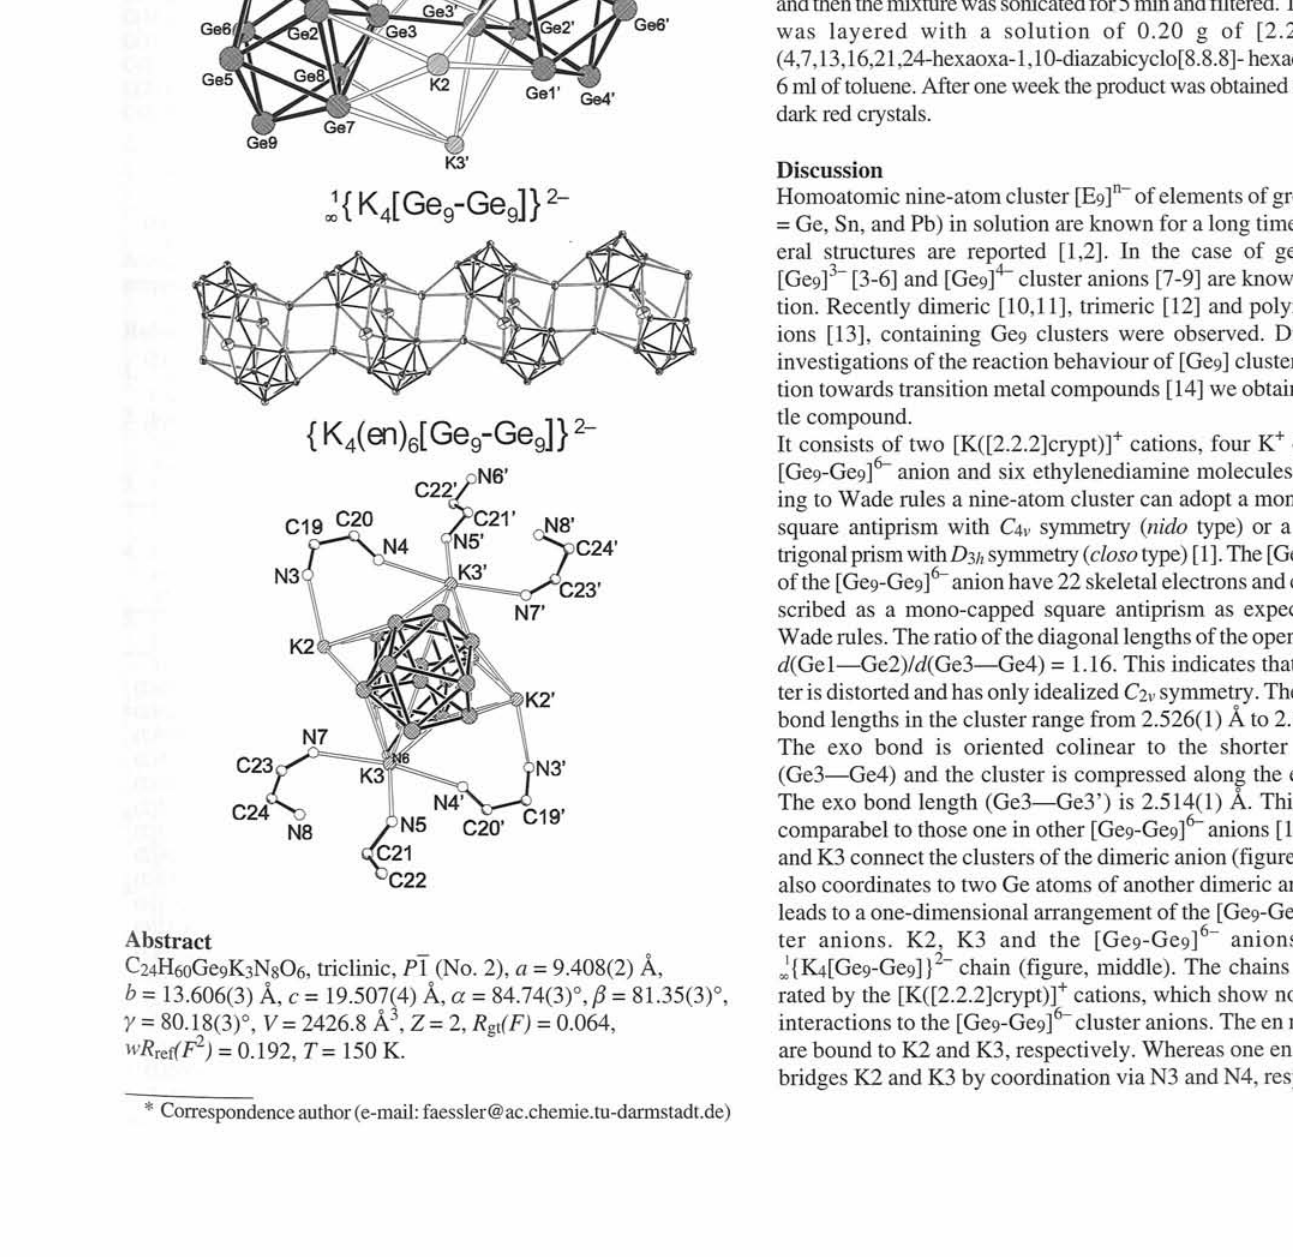
C24H6oGe 9 K3N 8 06, triclinic, PI (No. 2), a = 9.408(2) Â, b = 13.606(3) Á, c = 19.507(4) À, a = 84.74(3)°, β = 81.35(3)°, y = 80.18(3)°, V = 2426.8 Á 3 , Z = 2, R gt (F) = 0.064, wR le{ (F 2 ) = 0.192, Τ =150